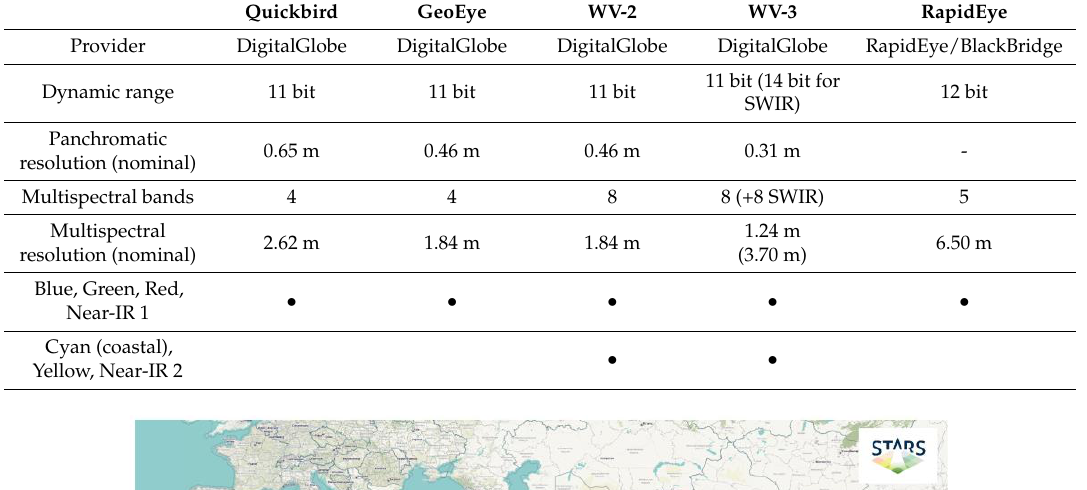
Table 1. Technical specifications of Very High Spatial Resolution (VHSR) satellite images ingested by